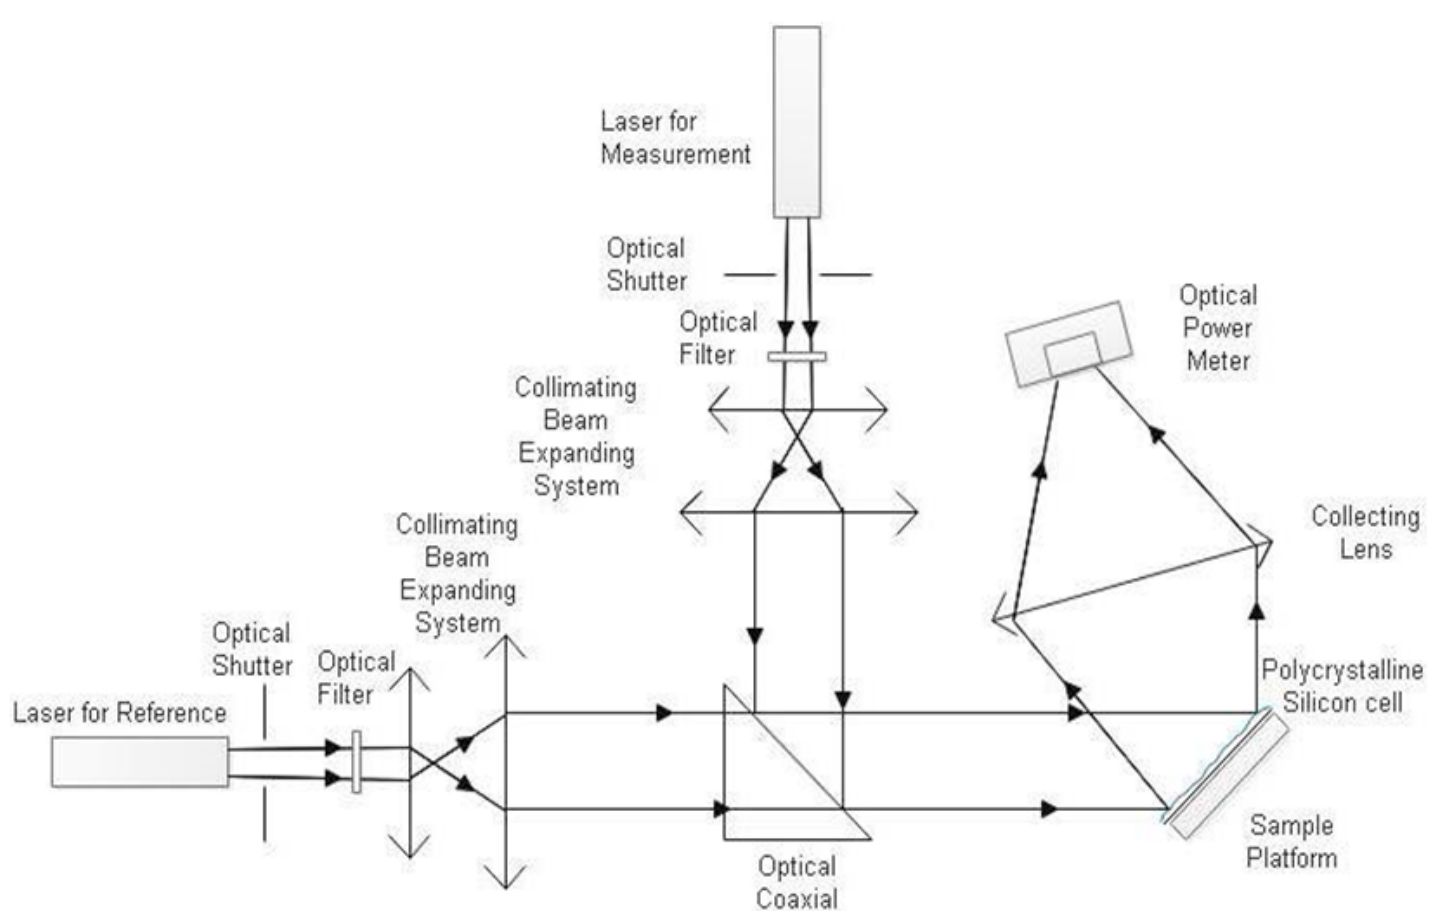
Figure 8. The schematic diagram of light path of the laser detection